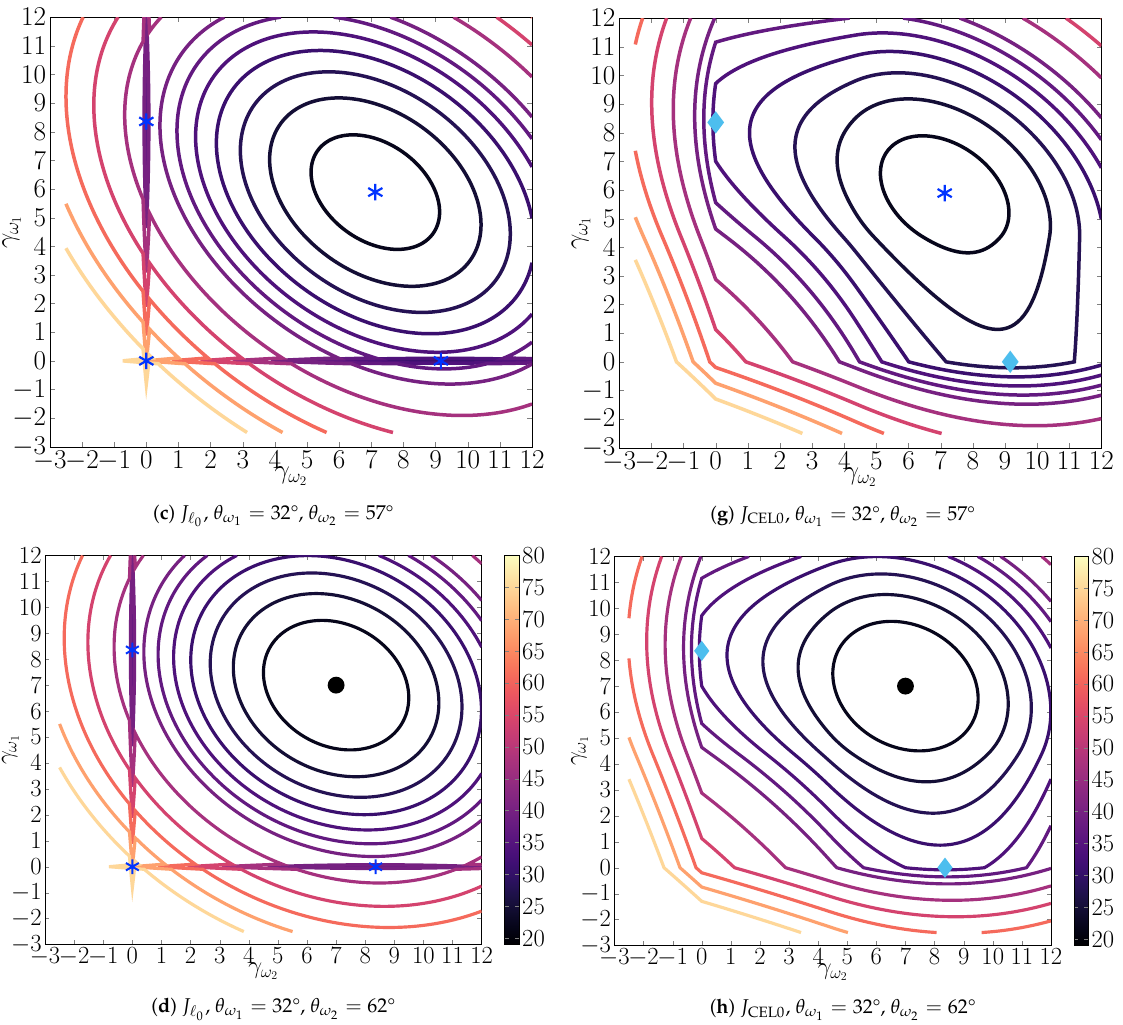
( a – d ) and J CEL0 ( e – h ) as a function of γ ω and γ ω , for γ = Z p ( γ ω ) , with (cid:93) ω = 2, i.e., at most 2 1 0 = ˜ θ 1 and a varying θ ω 2 . When those directions correspond to the 1 = γ ω = 7) is equal to 2 1